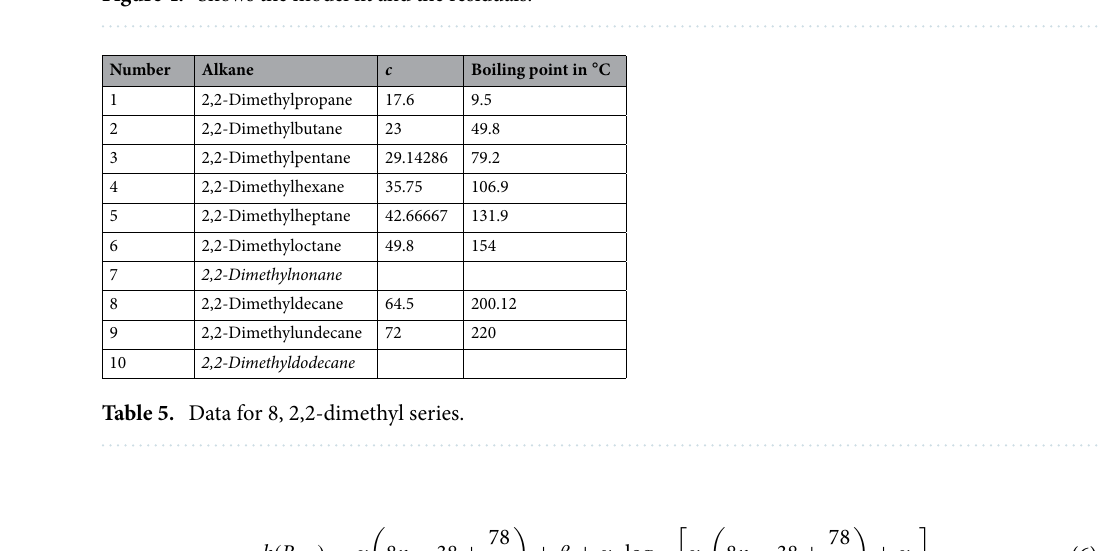
Figure 4. Shows the model fit and the residuals.